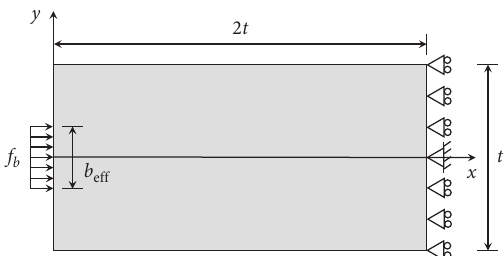
Figure 4: Structural analysis model for anchorage zone without a duct hole (plan